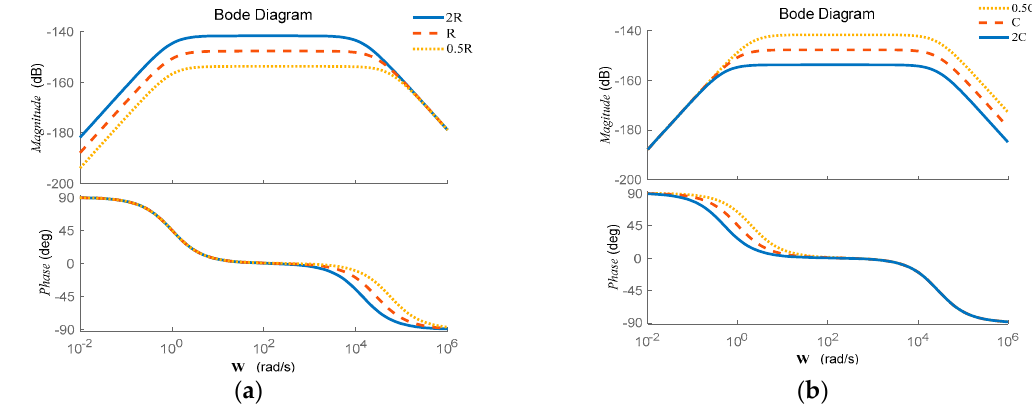
Figure 5. ( a ) Frequency characteristics of different resistances and ( b ) Frequency characteristics of different integral capacitances.